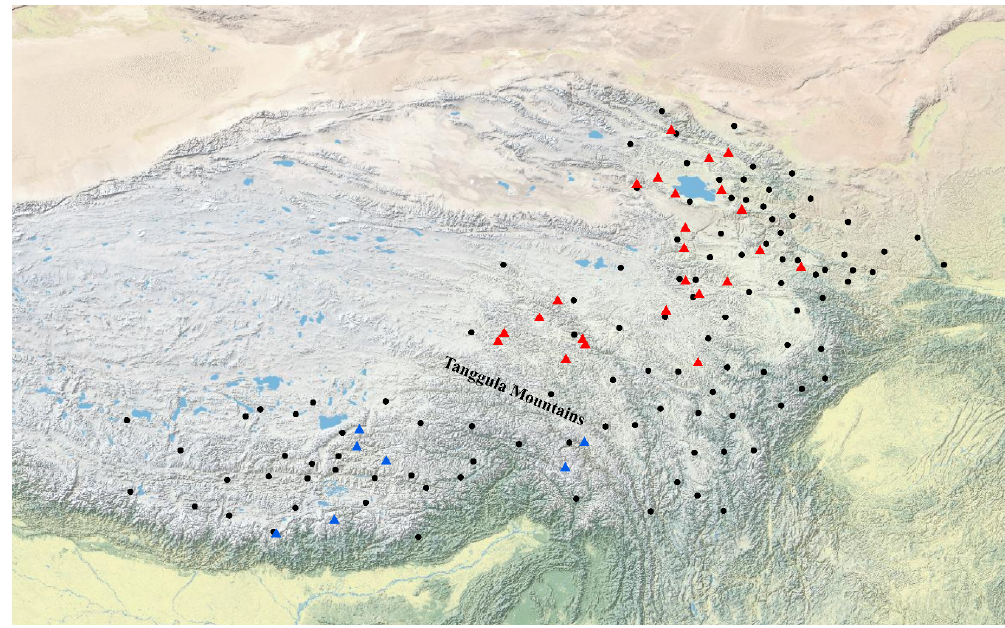
Figure 6. Geographic distribution map of L. tibetica (black dots represent herbarium records in the Chinese Virtual Herbarium, the red triangles represent the northern branch, the blue triangles represent the southern branch).